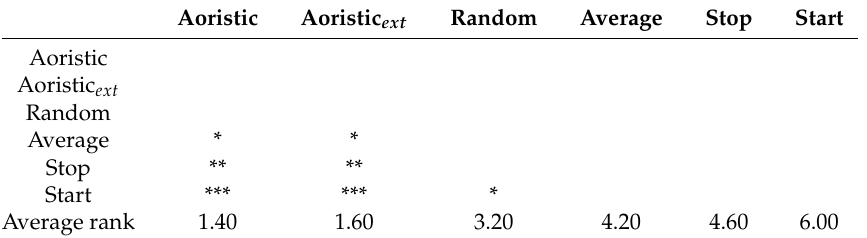
Table 10. Nemenyi significance test results from pair-wise comparisons between temporal analysis methods in the temporal resolutions of hour in the day with reduced number of available crimes during analysis.